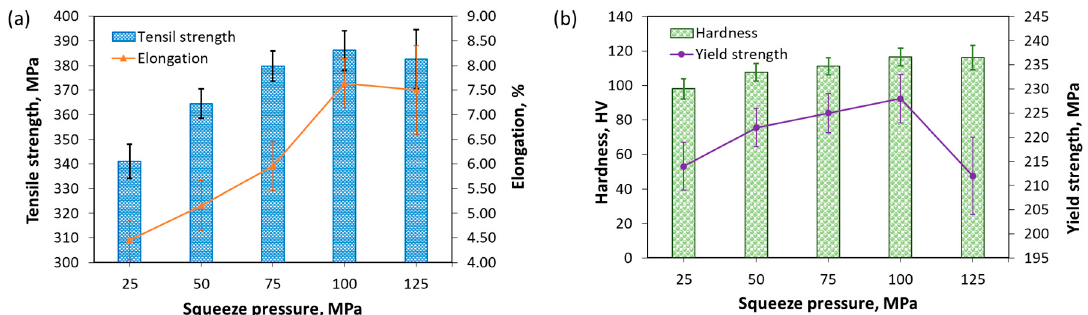
Figure 10. Effects of squeeze pressure on the mechanical property of scrolls: ( a ) tensile strength and elongation; ( b ) yield strength and hardness.